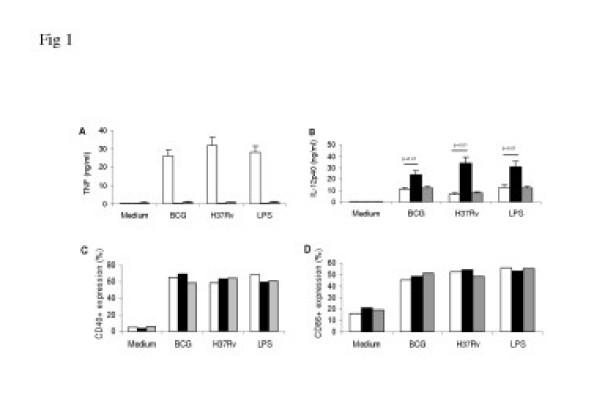
Defective soluble TNF and augmented IL-12 production from mycobacterial stimulated macrophages, and normal upregulation of CD40 and CD86 costimulatory molecules. Mycobacteria induced TNF (A) and IL-12p40 (B) production at 24 h TNF in the supernatant of macrophages from WT (open bars), TNF-deficient (black bars) and mem-TNF mice (grey bars) infected with BCG or H37Rv (at a MOI of 2) or stimulated with LPS (100 ng/ml). Data are expressed as the mean ± SD (n = 2 mice from one out of 4 independent experiments). TNF independent expression of costimulatory molecules CD40 (C) and CD86 (D) analysed by flow cytometry in macrophages stimulated as above. Results are expressed as mean percentage.